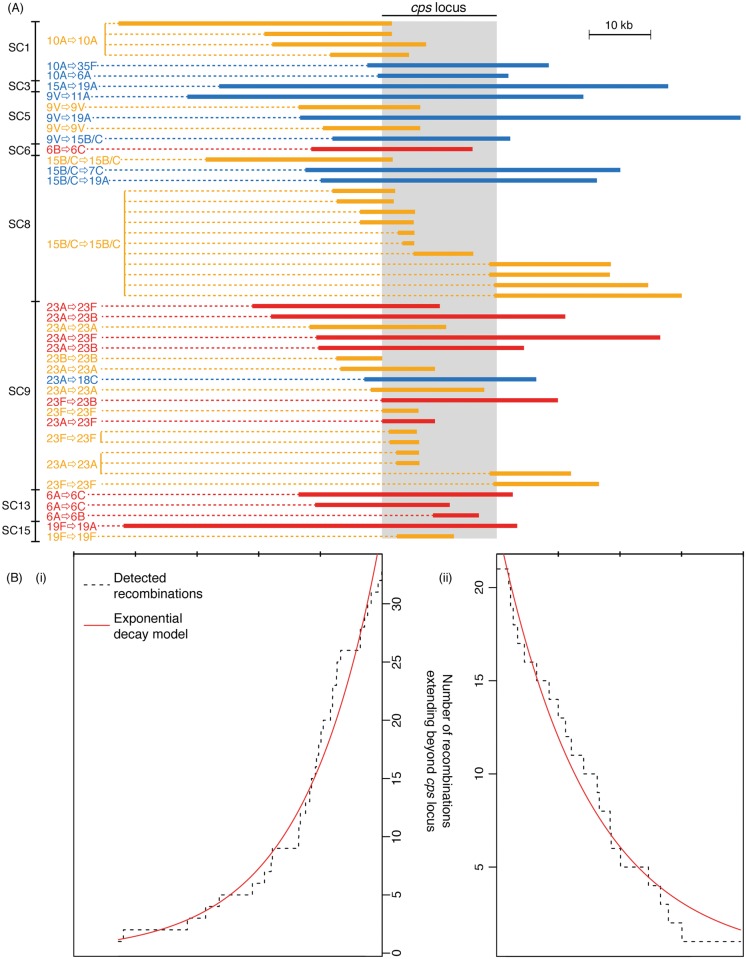
Extent of recombinations affecting the cps locus.(A) Positions of recombinations affecting the cps locus. Each of the recombinations identified in Fig. 3 is represented by a horizontal bar coloured according to the inferred impact of the recombination. Recombinations causing a change in serotype are uniquely annotated to correspond with Fig. 3. The grey column represents the extent of the cps locus; the width displayed is that of the longest cps locus across the different sequence clusters, and each recombination is scaled relative to the positions of this cps locus’ boundaries. (B) Extent of recombinations affecting the cps locus. The degree to which the recombinations displayed in (A) impinge on the flanking regions is summarised, with the dashed line representing the falling numbers of recombinations extending to bases further removed from the cps locus edges (displayed on the same scale as (A)). The red lines represent the fit of exponential decay curves to these trends. The tick marks above the plots represent 10 kb intervals.